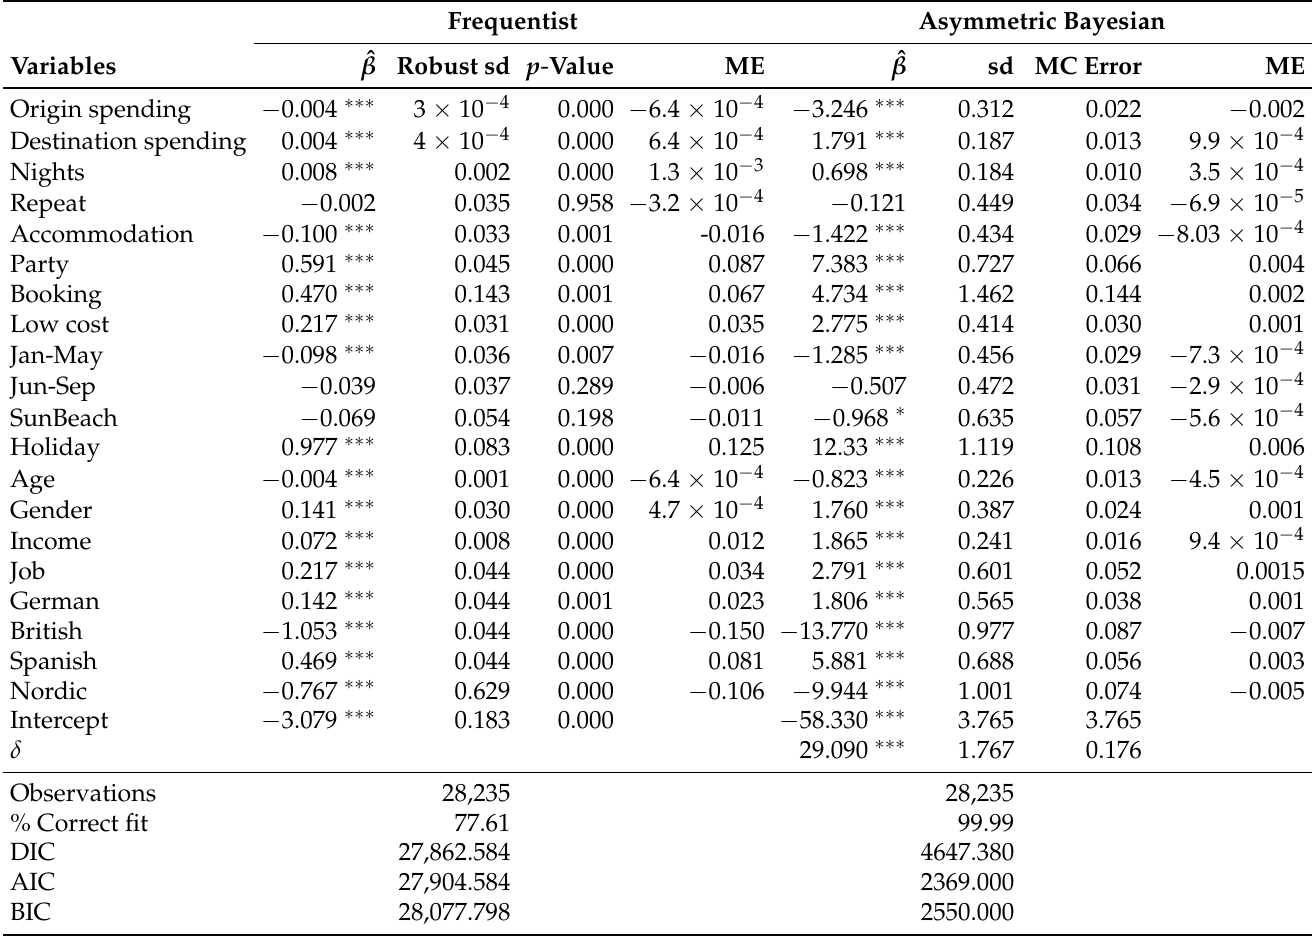
Table 2. Frequentist and non-informative asymmetric Bayesian